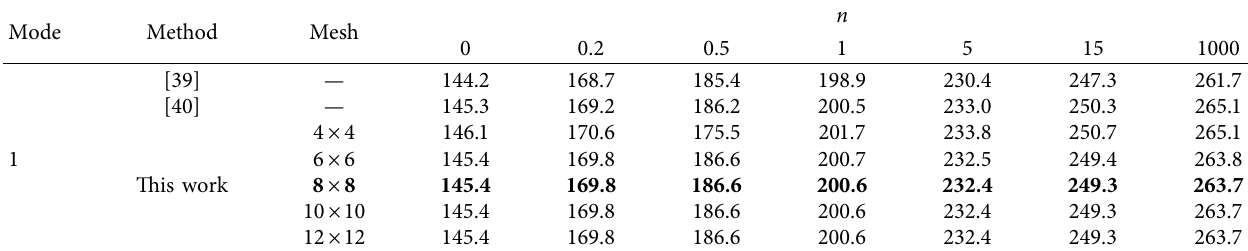
Table 2: Comparison of first natural frequencies (Hz) with some meshes.